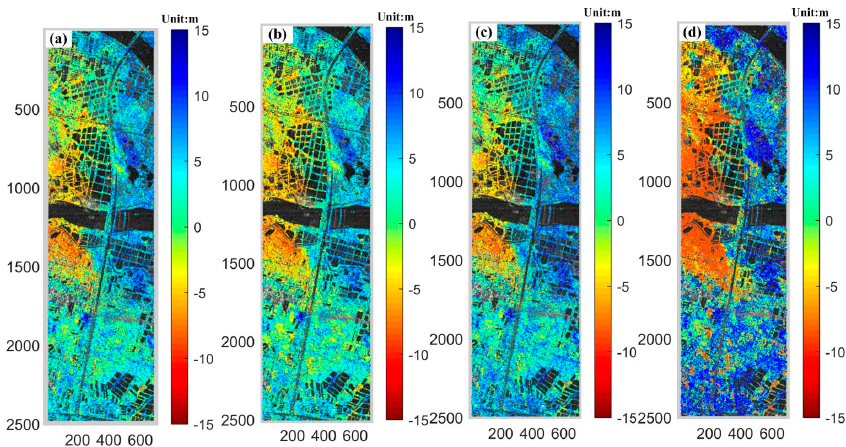
Figure 10. Height correction for 4 models: ( a ) MVM; ( b ) PVM; ( c ) SM; ( d ) CPM.